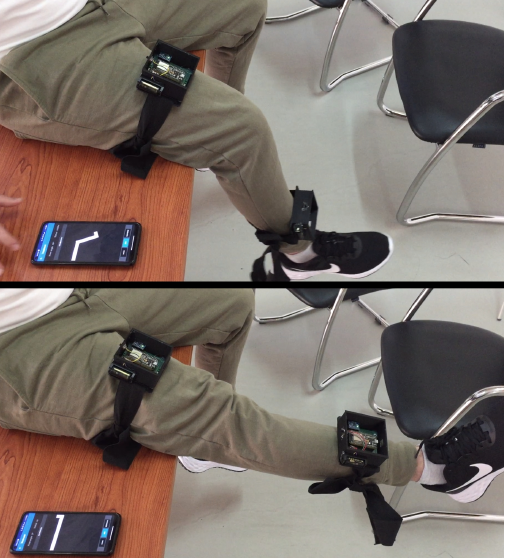
Figure 14. Wearable system and mobile app recognizing the movement of a volunteer’s